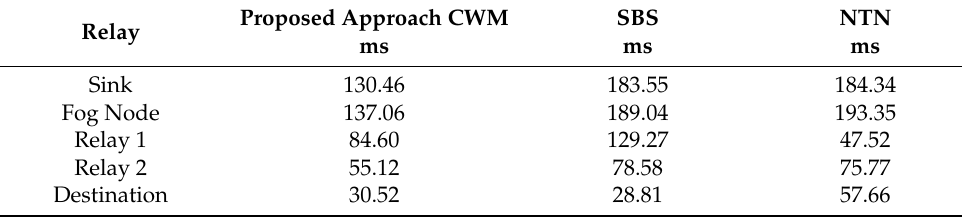
Table 5. Nodes time in active mode using 2 Relays.